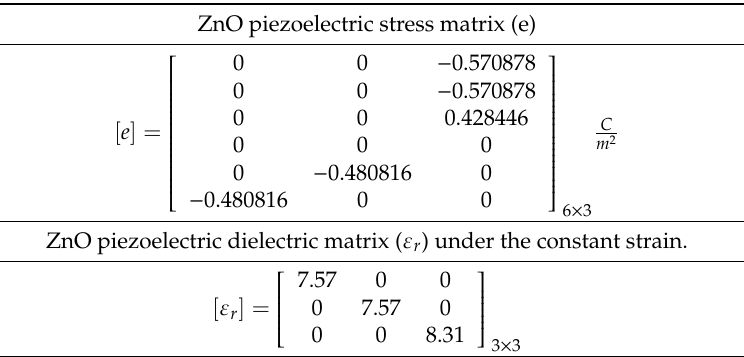
Table 4. Zinc oxide (ZnO) piezoelectric matrices used in the FEM models of the piezoelectric nanogenerator [44].